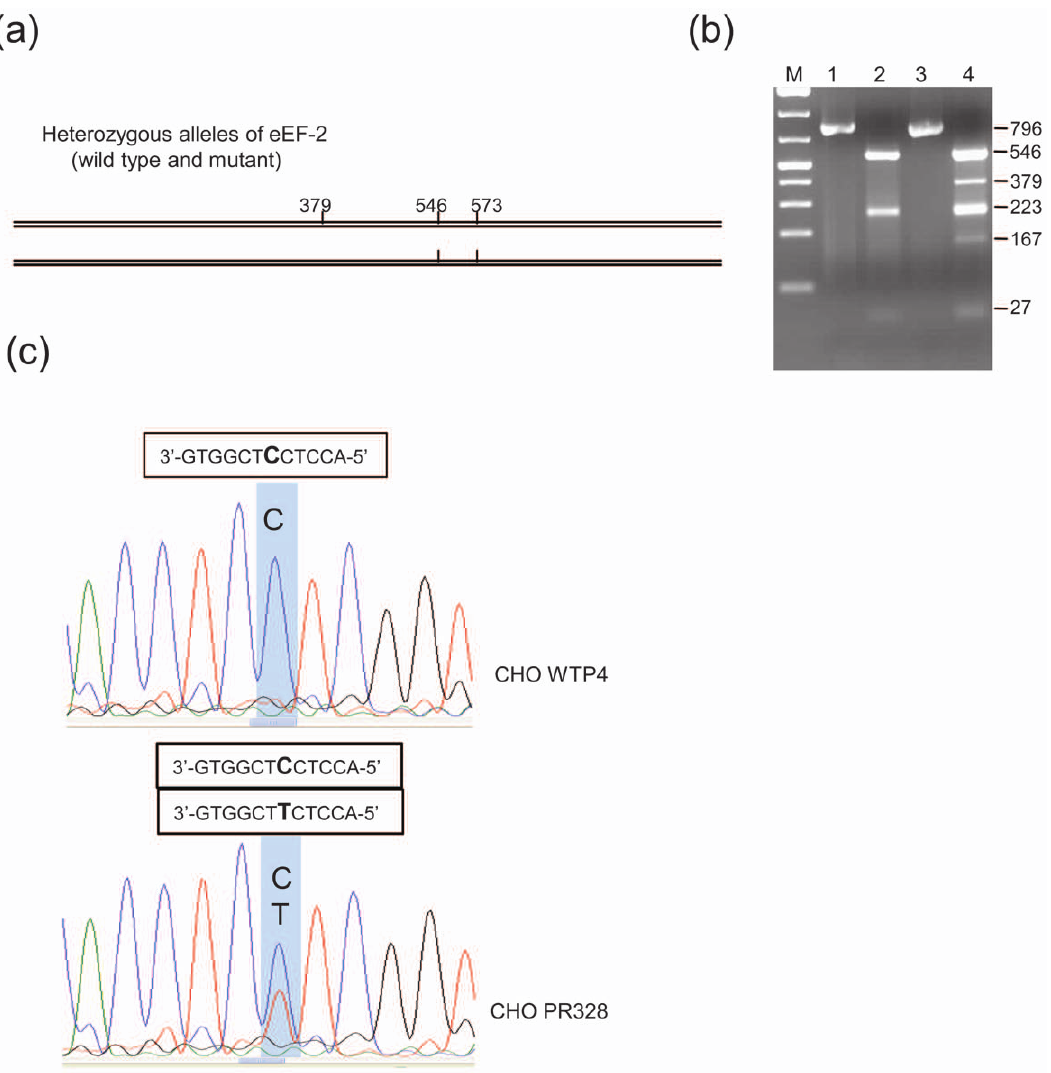
Figure 3. Genotyping of eEF-2 from CHO WTP4 and CHO PR328 cells. ( A ) Schematic representation for the presence of MboII restriction sites in heterozygous alleles in a 796-bp eEF-2 PCR product. Double lines indicate the two alleles of eEF-2 while vertical small lines show the sites for MboII restriction enzymes. There are two sites in wild type eEF-2 (bottom line) while the G to A transition introduces one more site in the mutant allele (top line). ( B ) RNA was extracted from CHO WTP4 and CHO PR328 cells using TRIzol reagent. RT-PCR was performed and amplified product was digested with MboII restriction enzyme. Digested DNA samples along with controls were then separated on 1% agarose gel and visualized using UV gel documentation system. M: 1 kb DNA ladder; Lane 1: CHO WTP4 control; Lane 2: CHO WTP4 digested; Lane 3: CHO PR328 control; and Lane 4: CHO PR328 digested. Presence of 5 bands is evident for CHO PR328 cells while CHO WTP4 cells shows only 3 bands on DNA gel. ( C ) RT-PCR samples obtained for the analysis of panel B were sequenced. Sequence shown is of complementary strand as reverse primer was used to sequence the region. Zoomed image shows the presence of two peaks (C & T) in eEF-2 of CHO PR328 cells as opposed to only one peak (C) in CHO WTP4 cells in the same region revealing the presence of G & A bases in eEF-2 of CHO PR328 at this location. As expected, CHO WTP4 eEF-2 had only G base at same